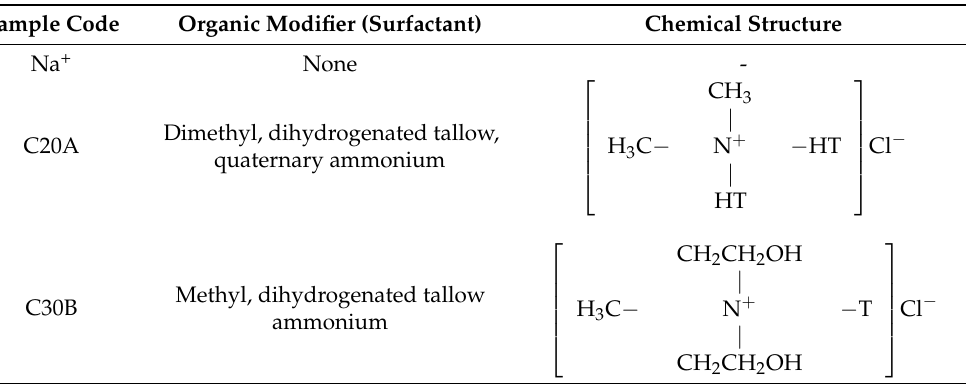
Table 1. Surface modifications of the nanoclays used in this work.